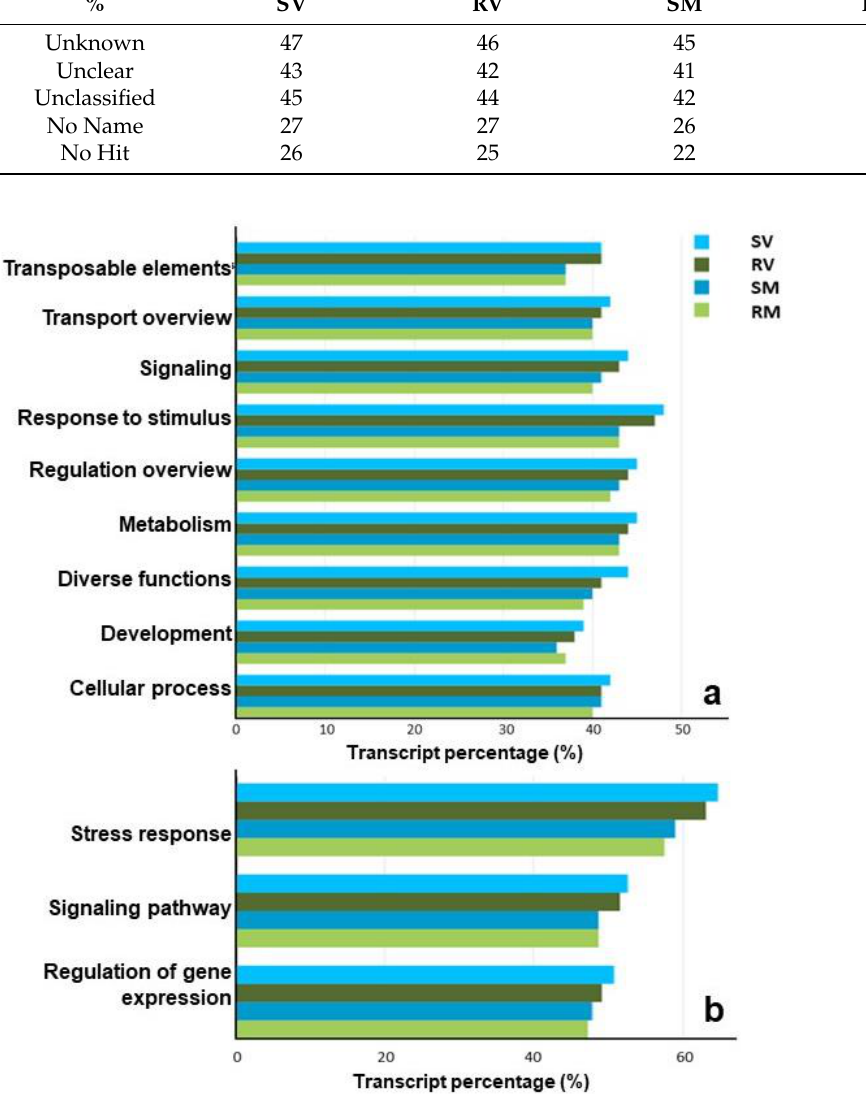
Figure 3. ( a ) Functional profiling of global gene expression for each RNA-Seq library, according to each transcript functional category. The number of active transcripts (length ≥ 150 and RPKM ≥ 1) per functional category was divided by the total transcripts from that category in order to normalize the expression profiles according to the number of transcripts on each class. The transcripts with no class defined in the reference transcriptome (CRIBI Grape genome) are represented in Table 2. ( b ) Sub-functional categories of “r esponse to stimulus ” . SV: Sustained deficit irrigation véraison ; RV: